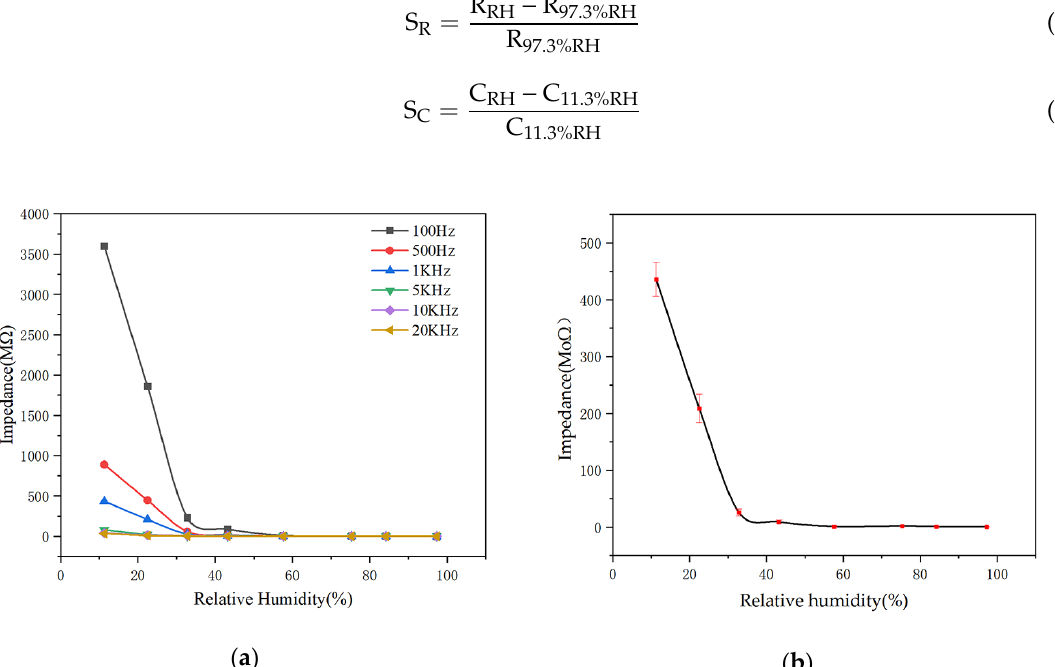
Figure 5. ( a ) Effect of humidity on the impedance of micro-arc MgO at different frequencies; Figure 5. ( a ) E ff ect of humidity on the impedance of micro-arc MgO at di ff erent frequencies; ( b ) 1 kHz ( b ) 1 kHz error graph. error